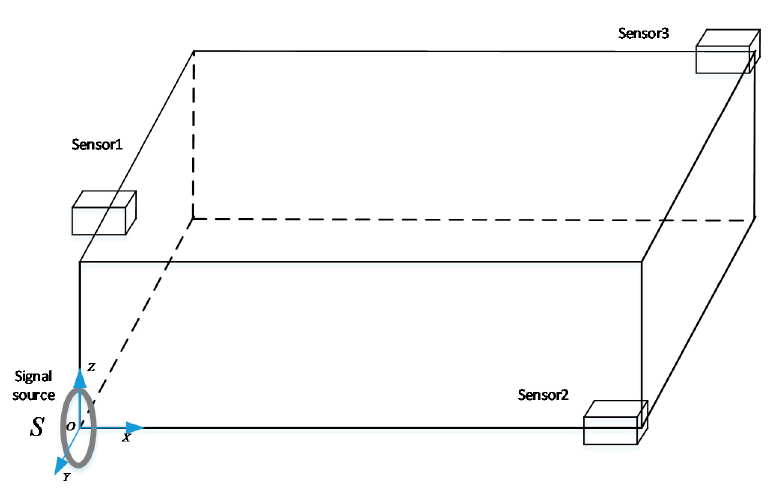
Figure 4. Position distribution of signal sources and sensors.